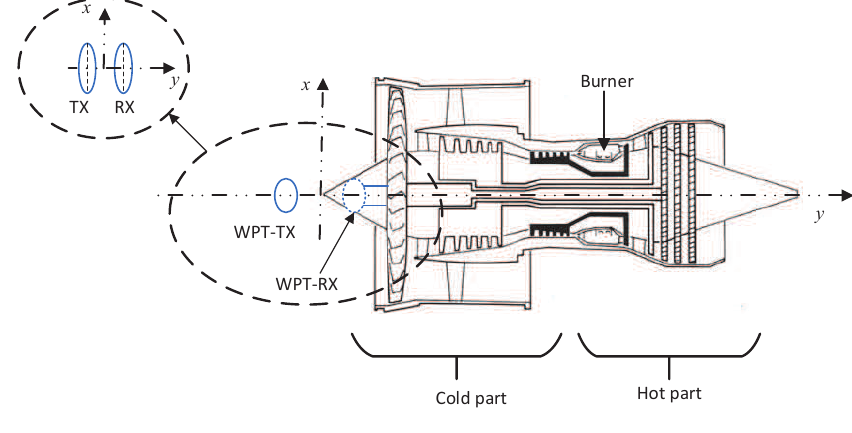
Figure 2. Diagram of the WPT system used in the gas turbine engine